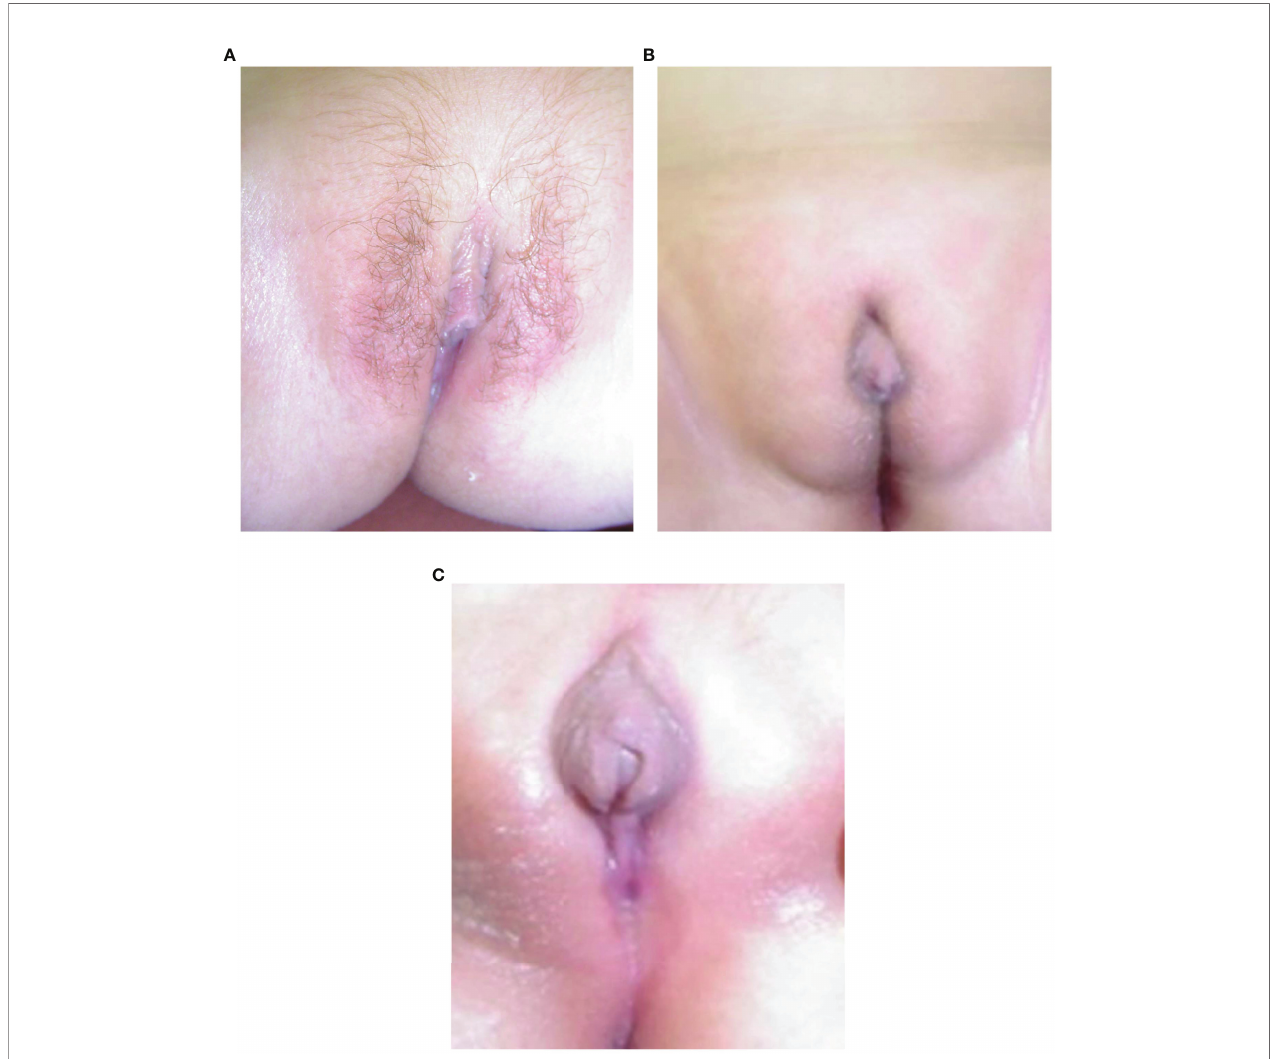
FIGURE 2 | (A – C) Appearance of external genitalia in two siblings from family E with 3 b HSD2 de fi ciency due to a p.P222Q mutation, showing virilization with clitoromegaly and pubic hair in the sister, E II-8 (A) and under-masculinisation in the brother, EII-9 (B, C)